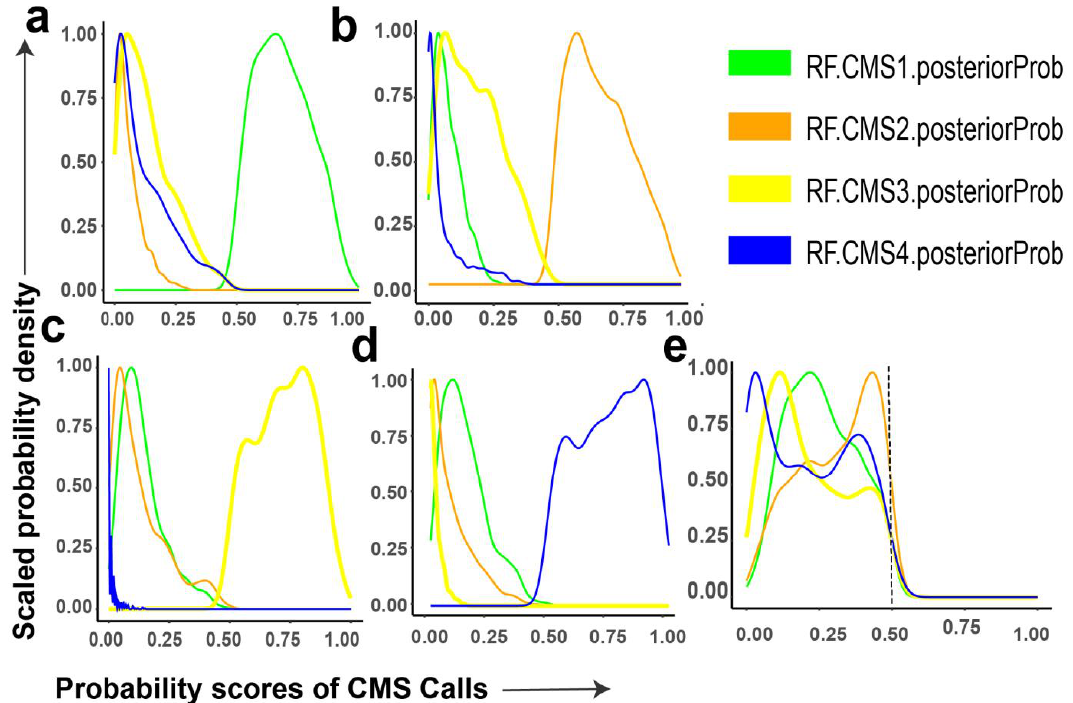
Figure 1. Probability densities of individual CMS calls from bulk RNAseq. ( a ) CMS1, ( b ) CMS2, ( c ) CMS3, ( d ) CMS4, ( e ) mixed group. Each CRC sample was assigned to a CMS if the probability of the CMS call was >0.50, tumors with no subtype having probability >0.50 were assigned to mixed group.